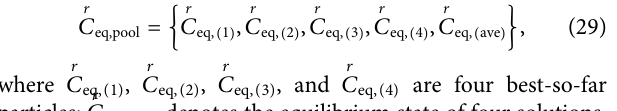
Frontiers in Energy Research |